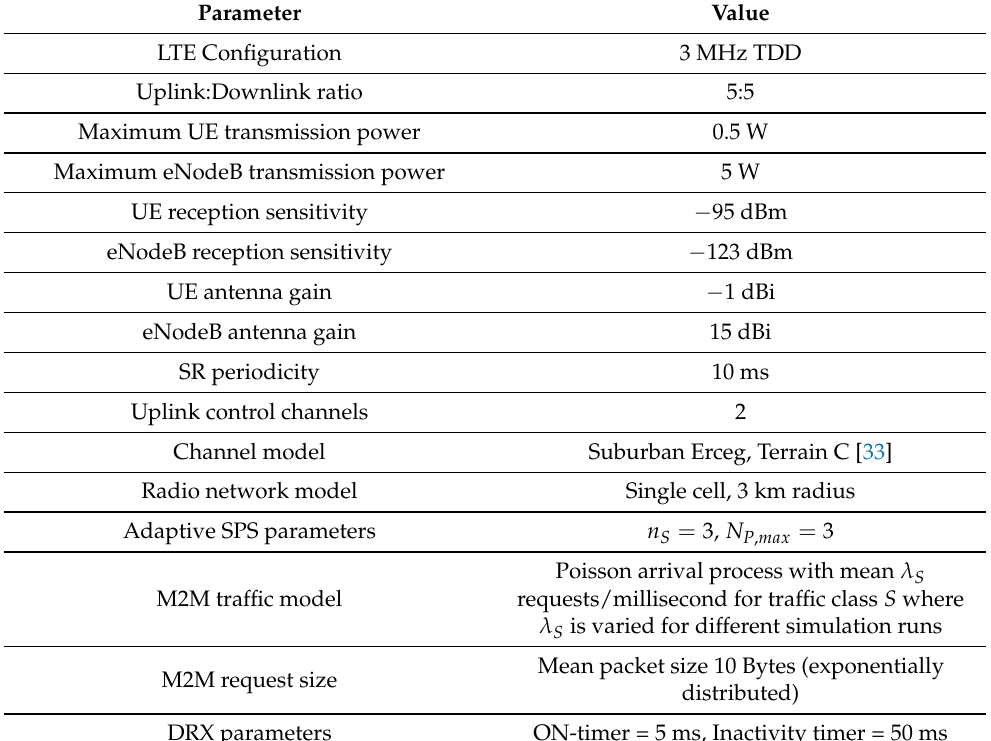
Table 1. Simulation Parameters.